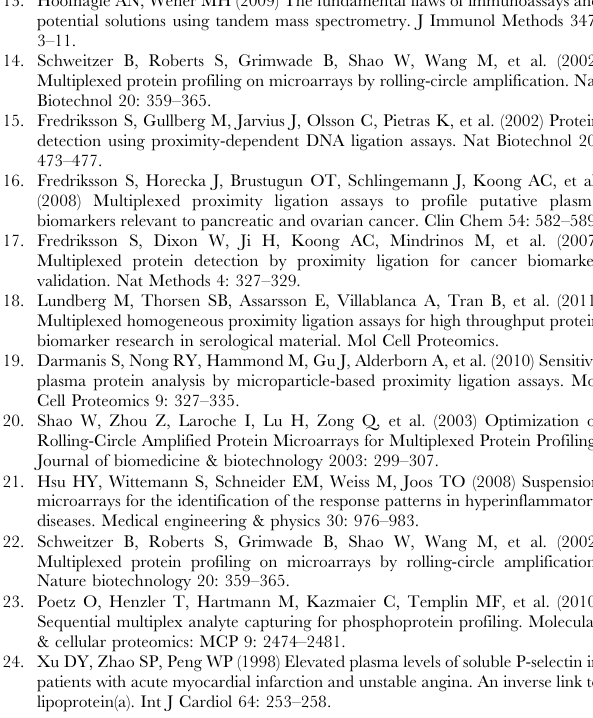
Figure S2 Limit of detection comparison between multiplex SP-PLA and sandwich immunoassay. The LOD of multiplex SP-PLA and sandwich immunoassay for every protein in the panel. The LOD is presented in Figure S3 Library preparation for sequencing. Sample barcodes are introduced in the pre-amplified ligation products by polymerization. Subsequently, barcoded samples are mixed in one tube prior to be sequenced. For more information please refer to the Methods section. Figure S4 Sequencing statistics. Columns indicate the absolute number of reads for each category in the x-axis. The number of reads of each category is also shown as a percentage of the total number of reads. Table S1 Conversion of molar concentrations to con- centrations in pg/ m l. The highest molar concentration (pM) for every protein used in the cross-reactivity experiment is converted to mass per volume concentration (pg/ m l). In addition reaction volumes are provided. Table S2 Detection limits for each protein included in the panel. The limits of detection for each protein included in the panel for both multiplex SP-PLA and sandwich immunoassays are presented in pg/ml. Table S3 Adjusted concentration of each PLA probe. Probe concentrations were adjusted in order to decrease PLA reporting efficiency and thus limit the dynamic range of different ligation products.